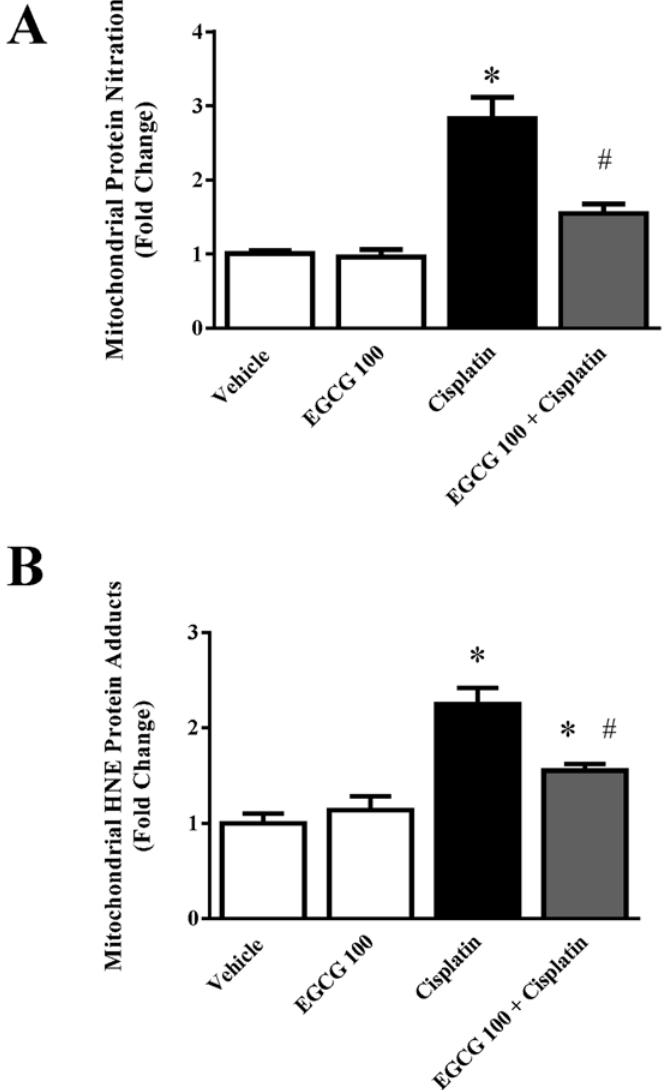
Fig 3. Effect of EGCG on cisplatin-induced oxidative/nitrative stress in mitochondria. Panel A. Quantitative measurement of protein nitration from mitochondrial fraction by ELISA demonstrated cisplatin induced content of protein niration. EGCG attenuated cisplatin induced mitochondrial protein nitration. Panel B. Quantitative measurement of HNE adducts from mitochondrial fraction by ELISA. A trend similar to protein nitration was also observed. Results are mean ± S.E.M. n = 4/group. * p < 0.05 versus vehicle; and # p < 0.05 versus